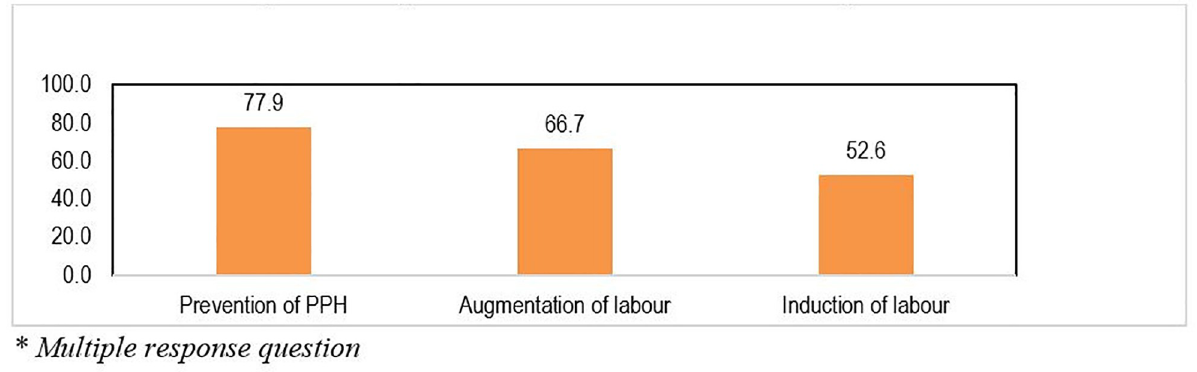
Fig 2. Respondents’ � indication for use of